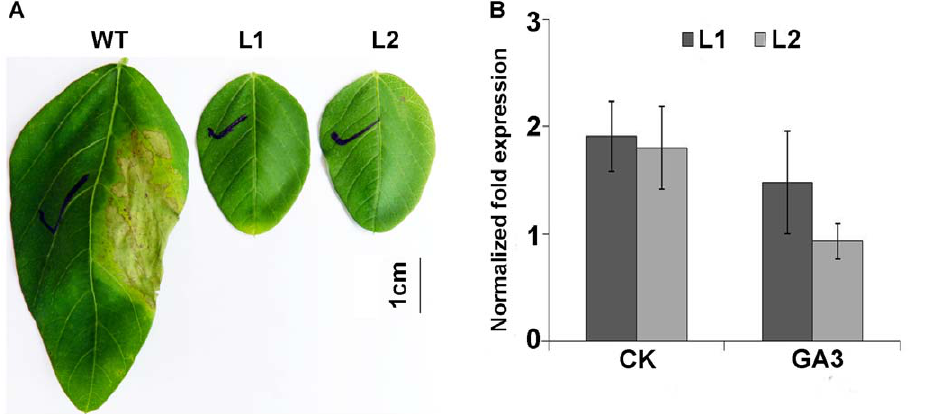
Figure 1. Herbicide tolerance and qRT-PCR analysis of transgenic plants. A: Detection of herbicide tolerance on AtDREB1A- transformed plants. B: Expression analysis of the AtDREB1A gene in transgenic plants. Data represents six biological replications, and error bars represent SE. WT, wide type; L1: AtDREB1A transgenic line 1; L2: AtDREB1A transgenic line 2; CK: control check, without GA 3 treatment; GA 3 : 144 m M GA 3 treatment.